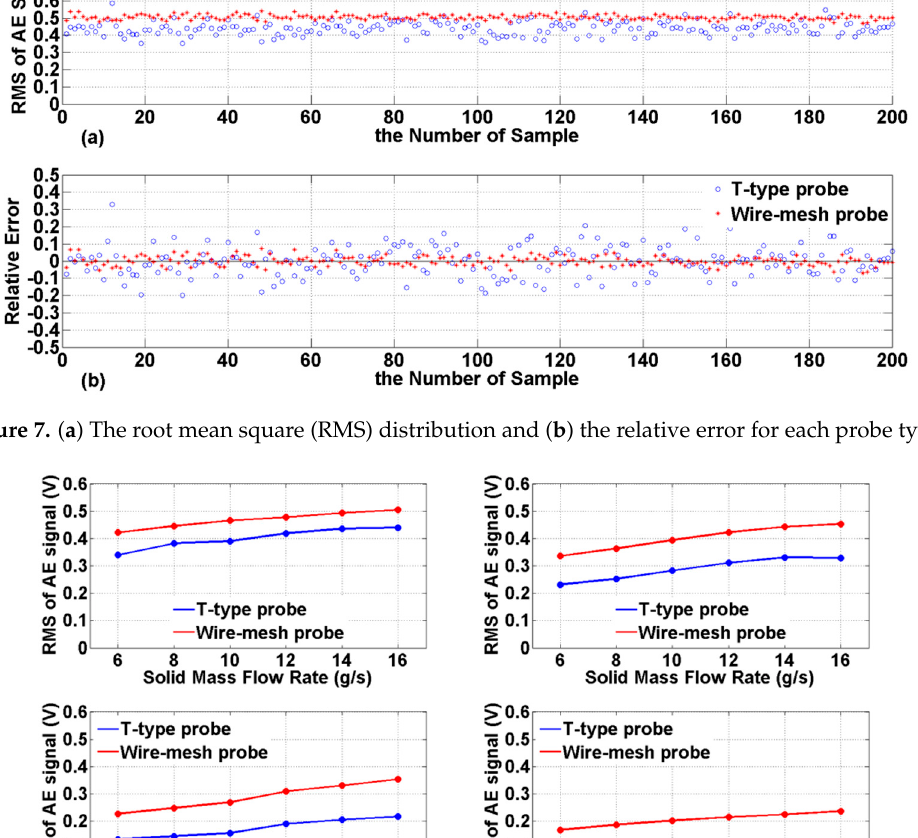
Figure 6. Raw AE signals selected at random and divided into samples.